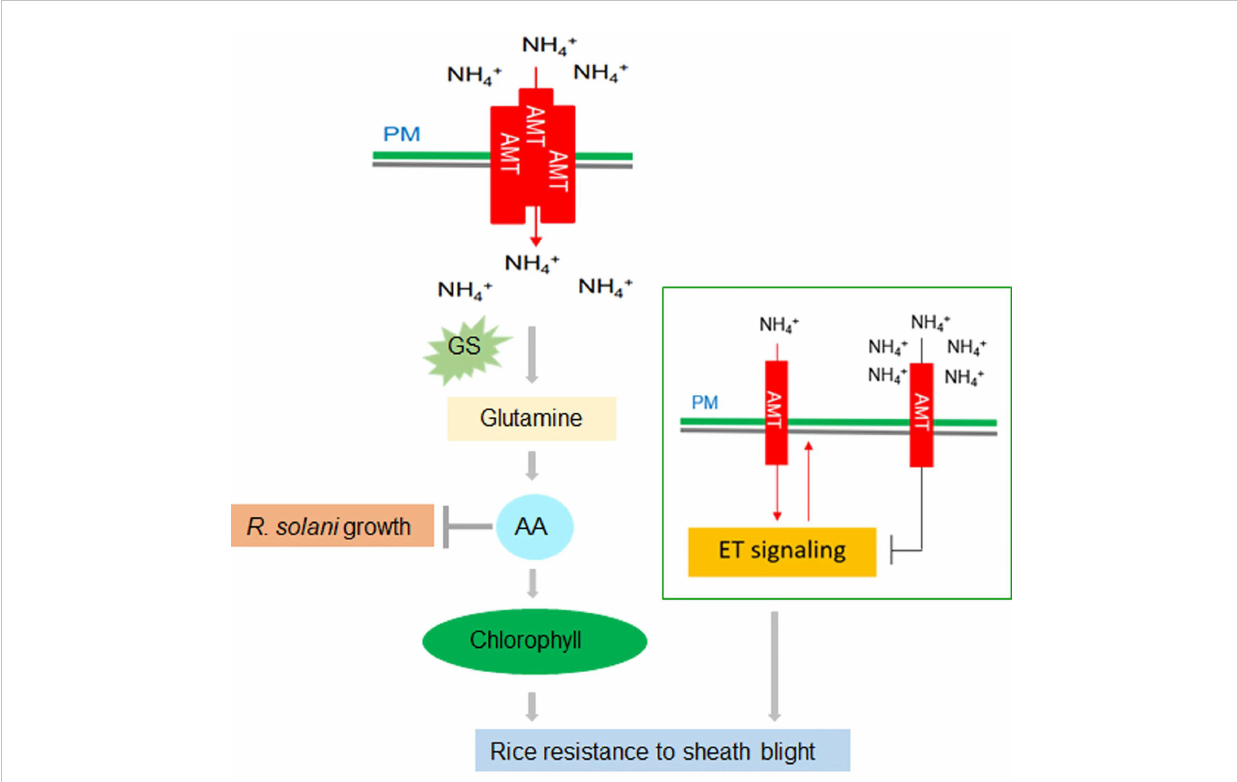
FIGURE 1 Crosstalk between hormones and ShB. IAA, ETH, SA, JA, BR, GA, ABA, CTK, and SL regulate ShB resistance. PIN1a is an auxin ef fl ux carrier responsible for auxin polar transport in rice. PIN1a positively regulates rice resistance to ShB. siR109944 expression is suppressed by R. solani inoculation. ACS2 leads to over-accumulation of ethylene. PBZ1 expression level is signi fi cantly induced in response to pathogen attacks. Following pathogen inoculation, the ACS2 levels and ethylene contents in ACS2-overexpression lines are signi fi cantly up-regulated, resulting in enhanced resistance to ShB. EIL1, the core component of the rice ethylene signaling pathway which regulates the expression of ethylene-responsive genes, positively regulating rice resistance to ShB. The SA signaling pathway in rice has two branches, one is the same NPR1-mediated pathway while the other is regulated by WRKY45. WRKY45 overexpression rice plants results in resistance to blast disease and leaf blight disease but has no positive effects (OPE) on ShB resistance. The function of NPR1 in the rice-ShB interaction remains unknown. Constitutive expression of transcription factor WRKY30 promotes JA accumulation and PR gene expression to increase ShB resistance in rice. JA positively regulates rice resistance to ShB. BR is a negative regulator of rice resistance to ShB. WRKY53 directly activates the expression of SWEET2a, a negative regulator of rice resistance to ShB, to confer susceptibility to ShB. SLR1 is the only DELLA protein in rice that inhibits GA signaling and its mutation signi fi cantly increases the disease susceptibility to leaf blight disease. ABA is primarily a negative regulator of immunity that regulates rice resistance to leaf blight disease and blast disease. The effects of SLs and CTK on the ShB process are not clear and require further